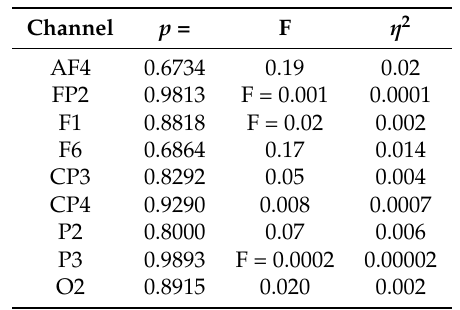
Table 3. Eyes-Closed (EC) setting. ANOVA analysis of GLM coefficients associated with the channels with significant difference in their total TEs between HIGH and LOW stress-susceptible groups. These channels were: FP2, AF4, F1, F6, CP3, CP4, P2, P3, and O2. This analysis identified a non-significant difference between contribution of these channels individually and in comparison with the other channels’ contribution.